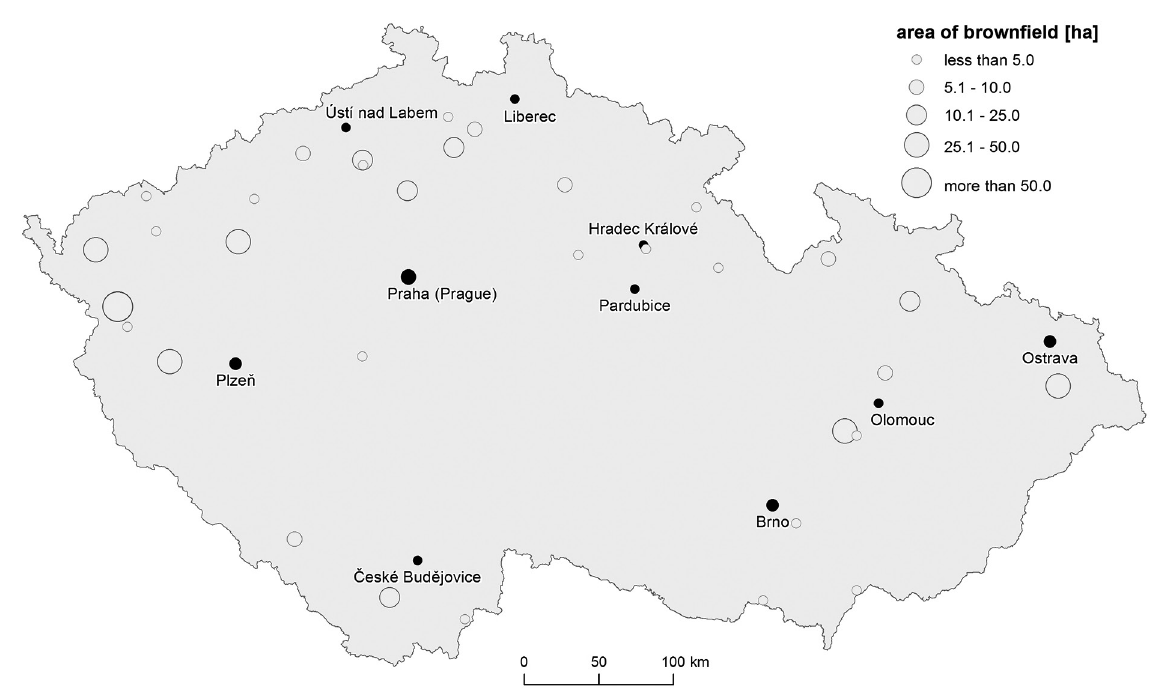
Fig. 2. Military brownfields offered to potential investors in the National Database of Brownfields (as of 15th January 2014) Source: CzechInvest (2014); authors’ own